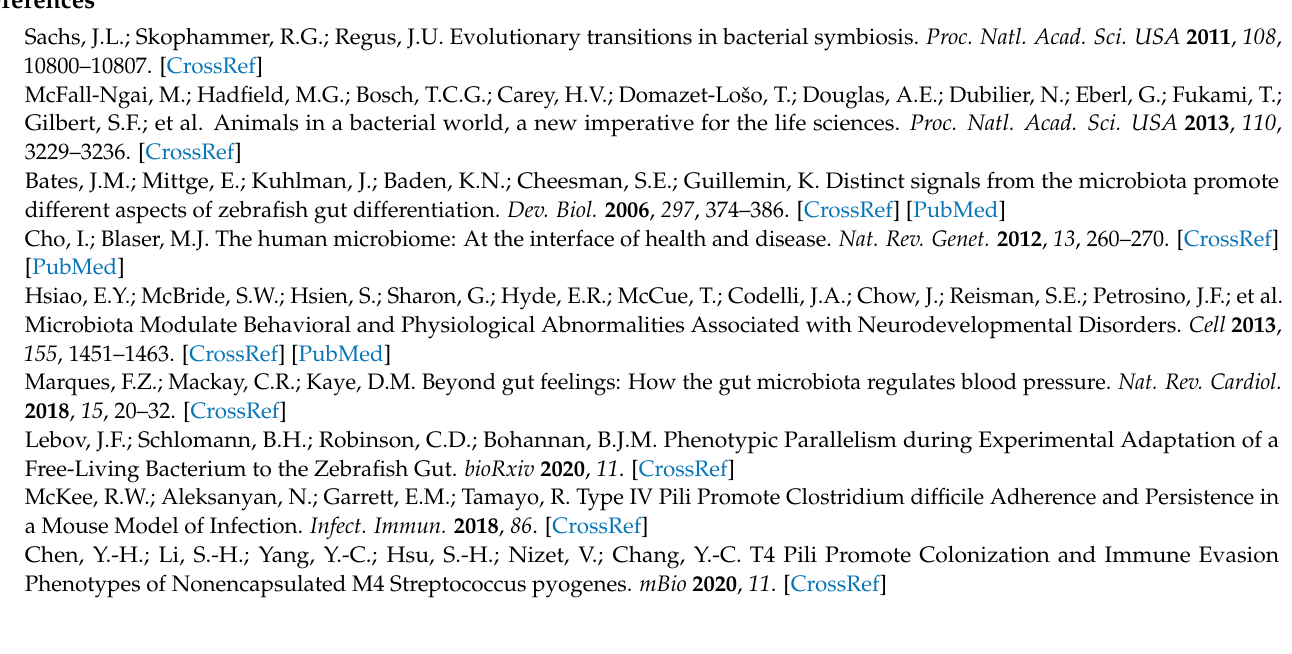
proteins, Figure S2: In vivo populations dynamics, Figure S3: Colonization and external population dynamics over time, Figure S4: Planktonic and near-flask population dynamics. Table S1: MR-1 MshL-300 representation, Table S2: Evolved